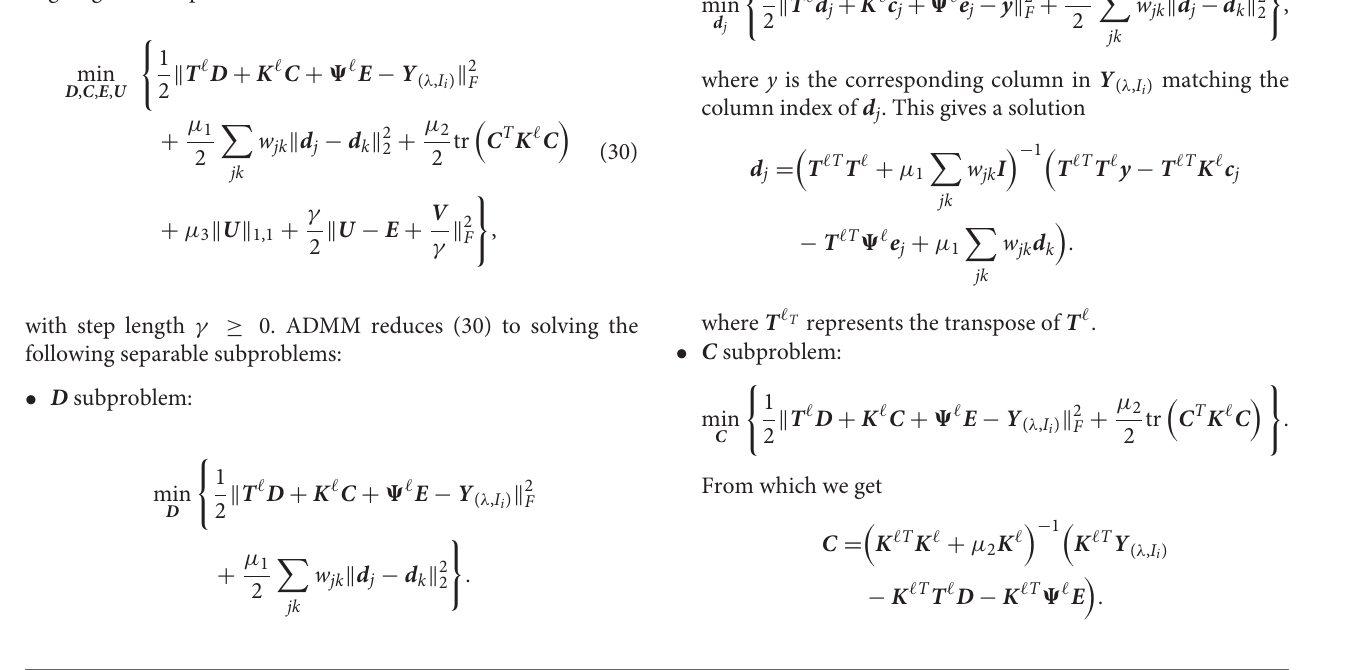
By introducing the augmented Lagrangian and completing the squares, we change the constrained optimization problem (29) into the following non-constrained optimization where V is Lagrangian